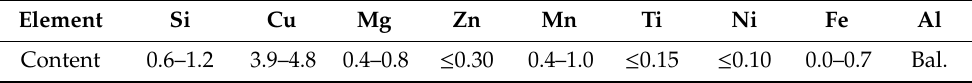
Table 1. Chemical compositions of the 2A14 aluminum alloy (wt.%).